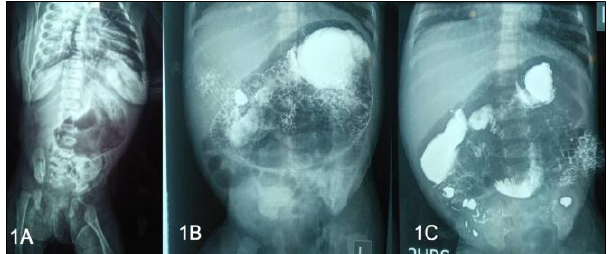
Figure1: A) Plain abdominal radiograph showing grossly dilated stomach and paucity of gas in the distal bowel, B and C) Barium meal and follow-through showing dilated stomach and duodenum and